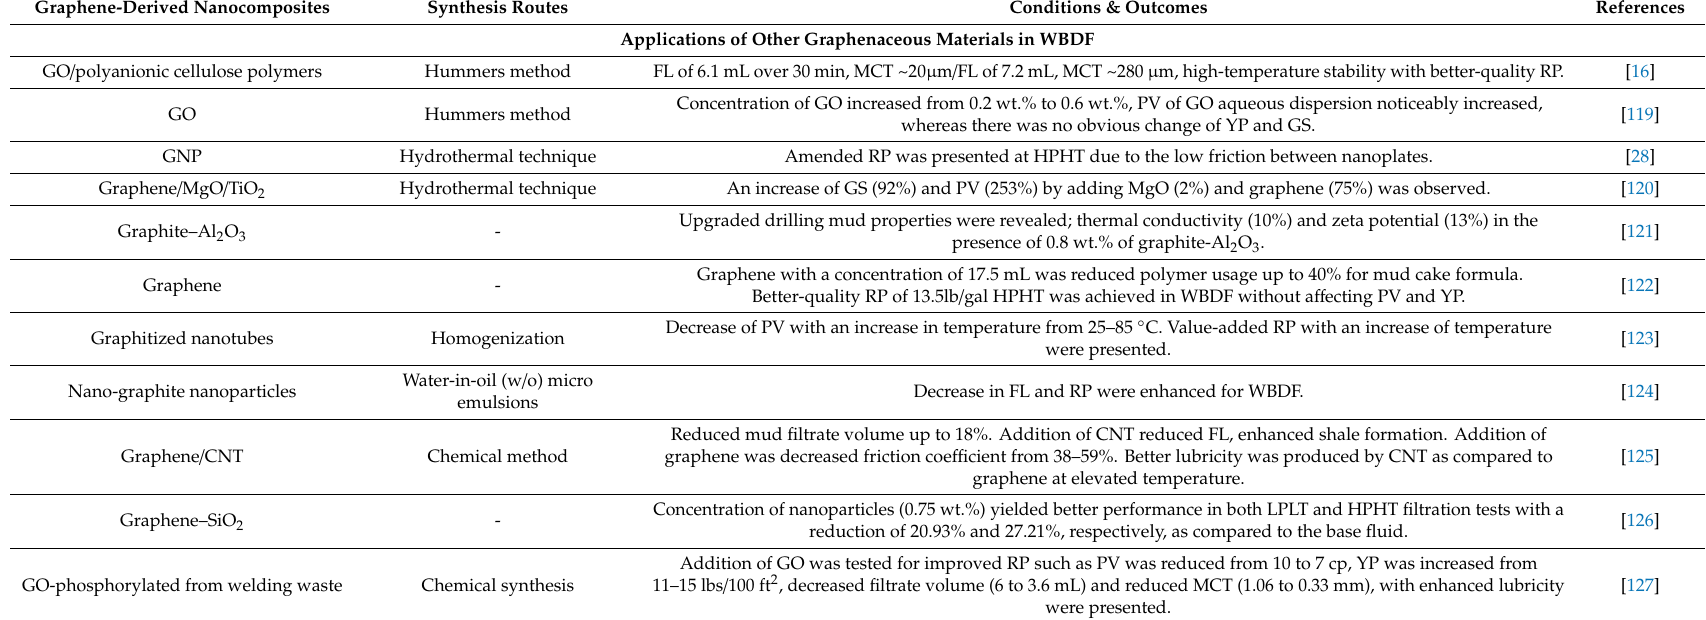
Table 2 includes the following designations; PV: plastic viscosity, SR: shear rate, RP: rheological properties, YP: yield point, ST: shear test, GS: gel strength, FL: fluid loss, MCT: mud cake thickness, CNT: carbon nanotubes, GNP: graphene